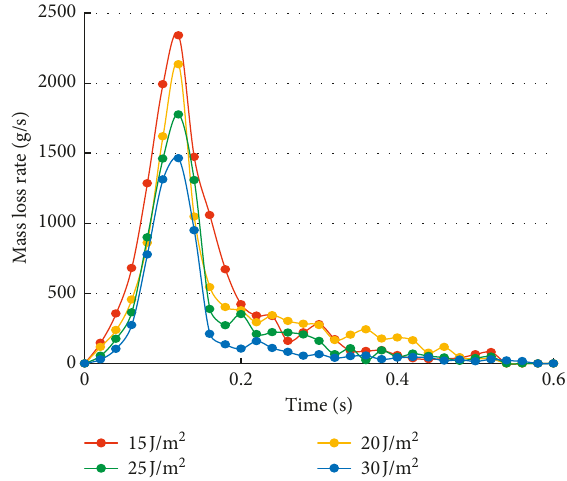
Figure 7: Porosity coefficients under different cohesive forces. Table 5: Permeability coefficients under different cohesive